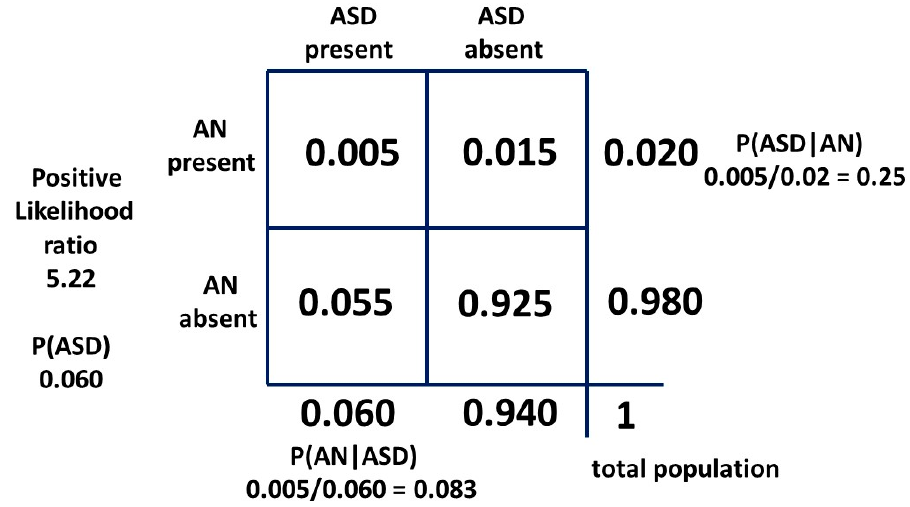
Figure 10. Bayesian 2 × 2 table for female population model two as probabilities.